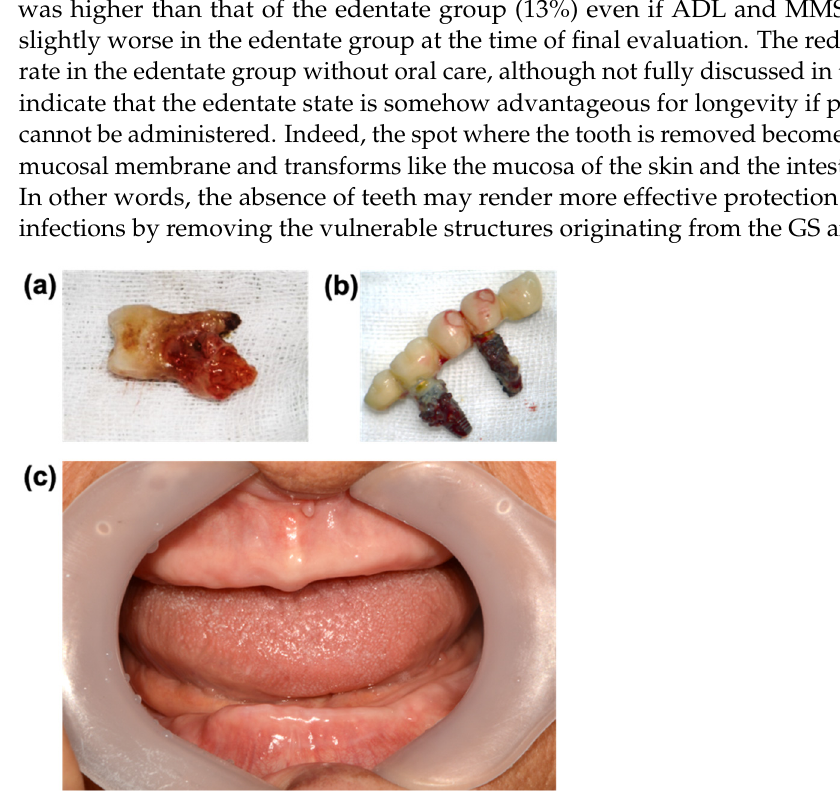
Figure 2. Biofilms built on ( a ) a tooth’s surface and ( b ) extracted implants. The hard surface of a tooth root, an implant, and a crown prosthesis abutting an implant shaft provide a solid ground on which biofilms can accumulate for a lifetime if not well cared for. ( c ) The edentate oral cavity. The toothless oral mucosa is free of the GS and the JE, making it less vulnerable to